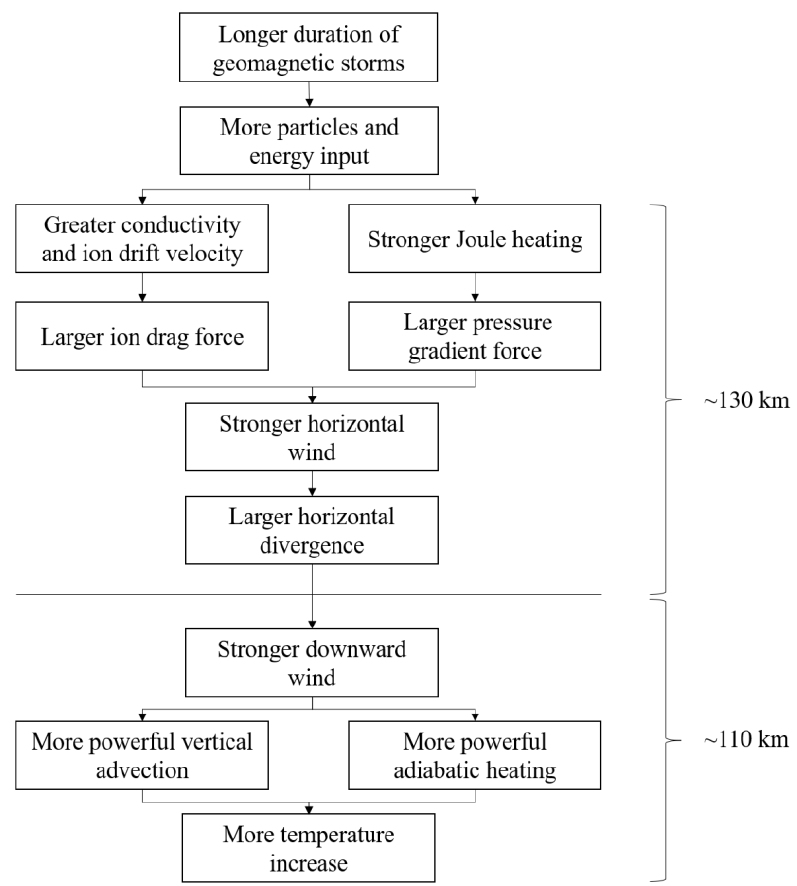
Figure 9. Schematic figure of the physical process of temperature increases due to geomagnetic storms with longer duration.